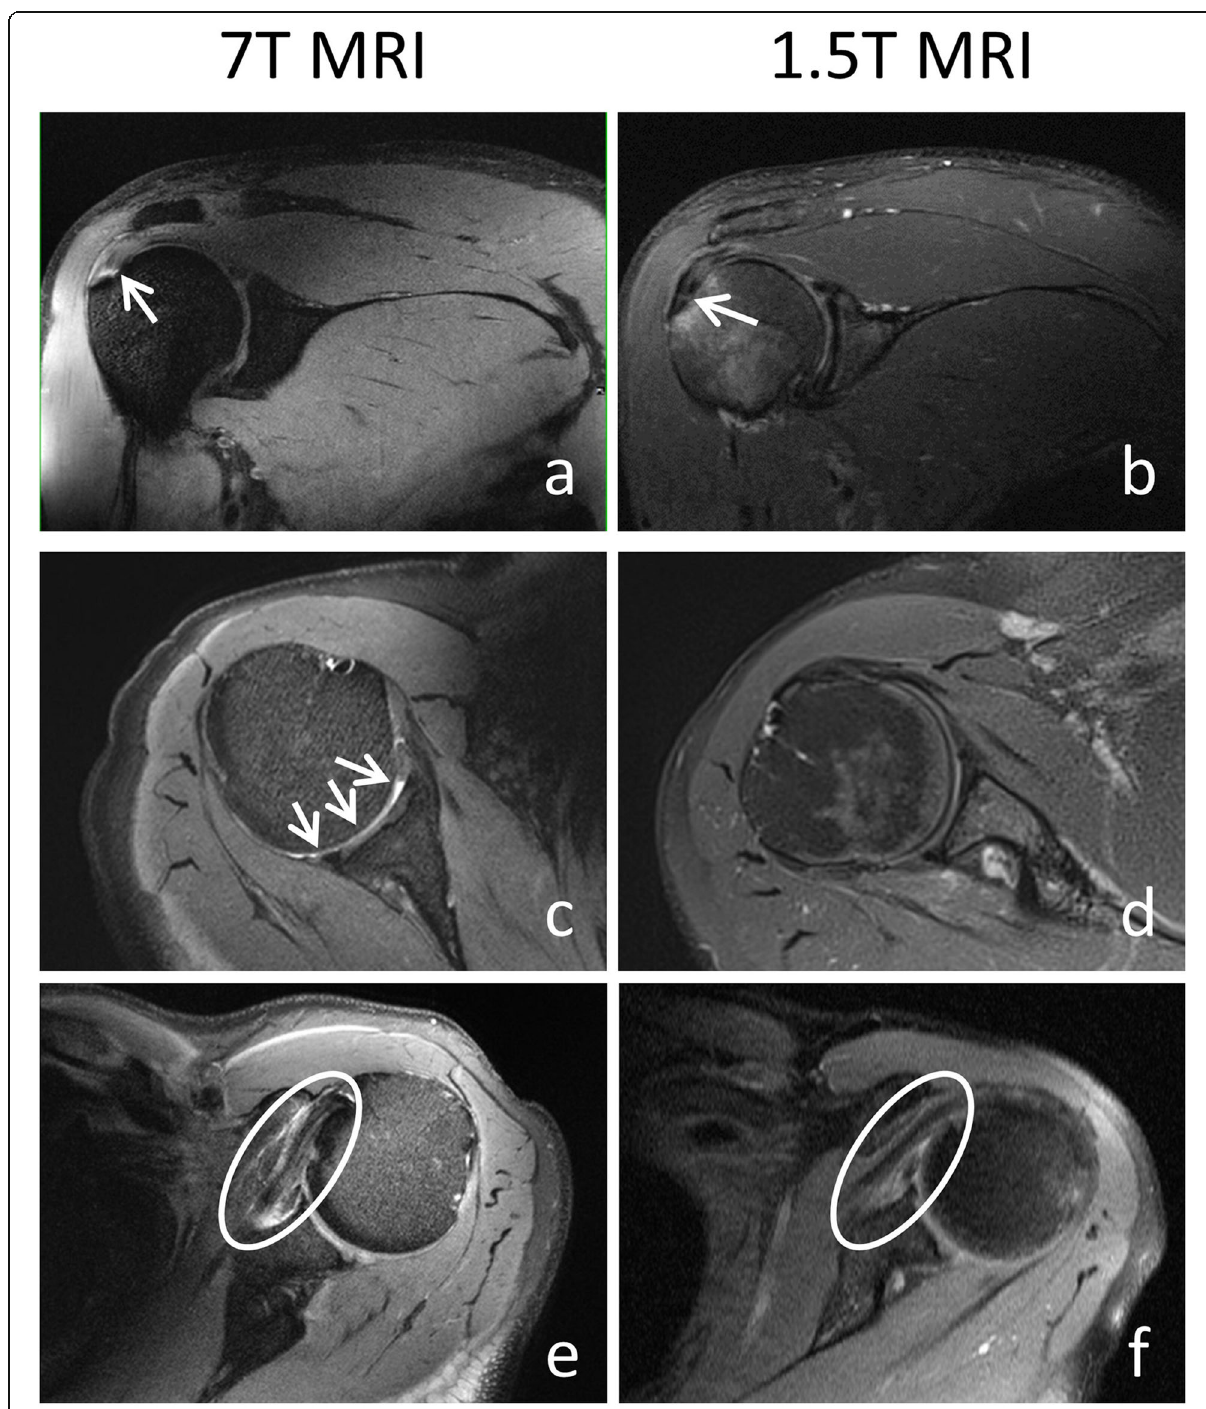
Fig. 4 Pathologic findings associated with shoulder pain at 7 T and 1.5 T, confirmed by arthroscopy. Coronal proton density (PD)-weighted fat- saturated images of the right shoulder of a 31 year-old male patient, showing a partial rupture of the supraspinatus tendon (arrows): the partial tear near to the footprint of the tendon is more distinct at 7 T ( a ) than at 1.5 T ( b ) because of higher tissue contrast. Axial PD-weighted fat- saturated images of the right shoulder of a 51-year-old female patient with irregularities and thinning of the humeral cartilage: due to higher image resolution, pathology can clearly be depicted at 7 T ( c , arrows), but not at 1.5 T ( d ). Axial PD-weighted fat-saturated images of the left shoulder of a 58-year-old male patient with tendinopathy of the subscapularis tendon (circle): the better tissue contrast and higher image resolution at 7 T ( e ) depicts thickening and oedema of the tendon much better compared to 1.5 T ( f